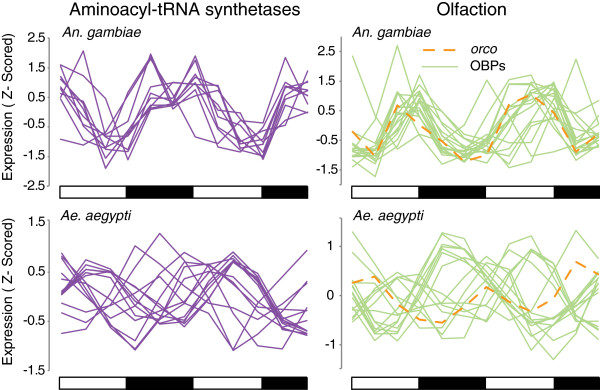
Multiple aminoacyl-tRNA synthetases and olfaction genes are rhythmic in both An. gambiae and Ae. aegypti. Expression profiles of all aminoacyl-tRNA synthetases and OBPs that were detected as rhythmic (q < 0.05), and orco (q = 0.06). An. gambiae appears to have tighter co-regulation of gene expression than Ae. aegypti. Expression data have been Z-scored. Aminoacyl-tRNA synthetases predicted using DAVID [103,104], Ae. aegypti OBPs from Zhou et al.[127], and An. gambiae OBPs are annotated in VectorBase. All data from LD heads. As Anopheles collection began at dusk (ZT 12) and Ae. aegypti collection at dawn (ZT 0), the second and third timepoints from the Anopheles collection are appended to the end of the collection as the last two timepoints for visualization purposes. Day and night are indicated by the horizontal white/black bars below the charts. All data shown are from LD heads.